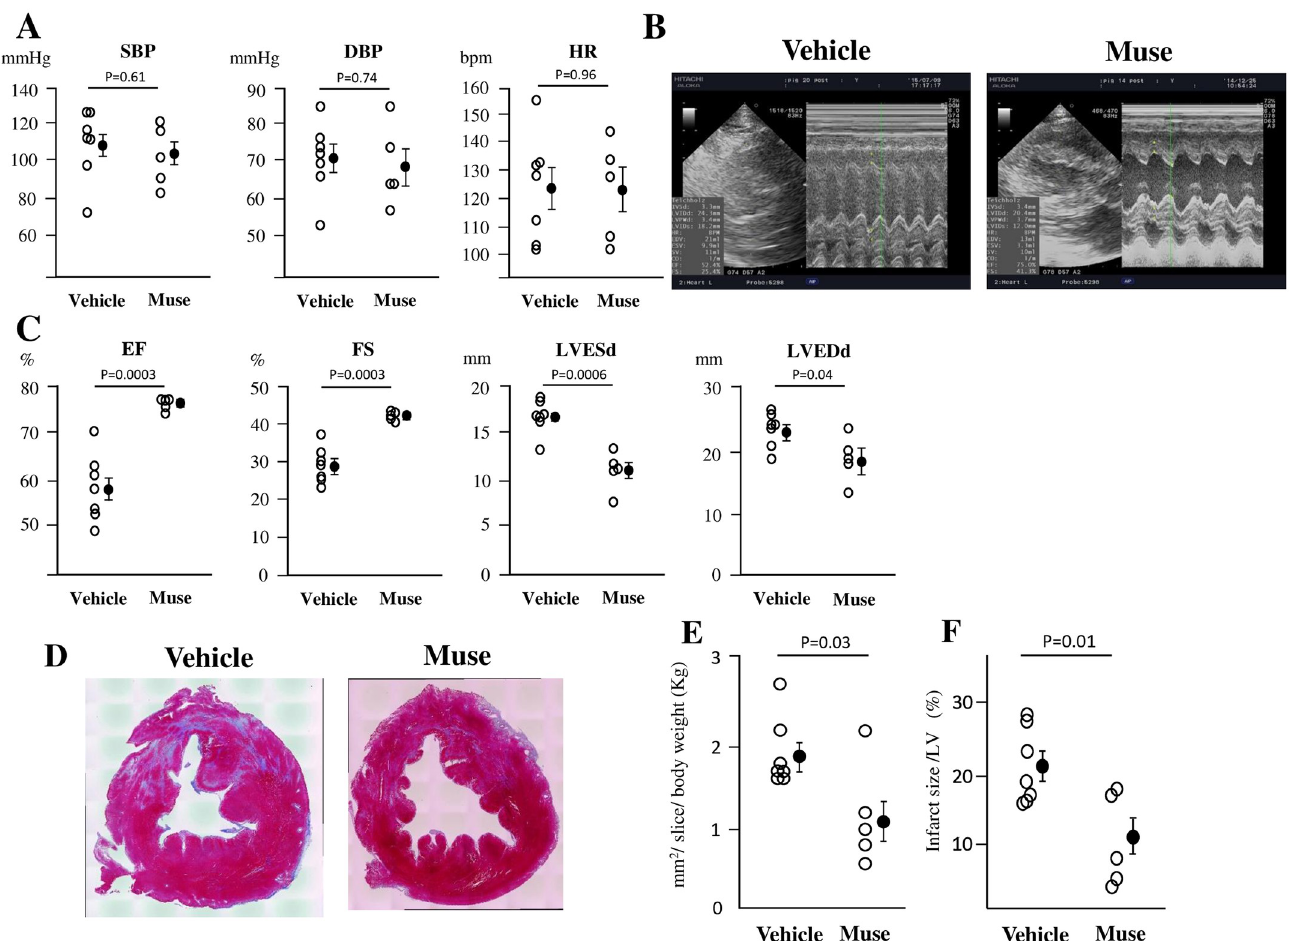
Fig 1. Cardiac function and myocardial infarct size. A: Systolic blood pressure (SBP), diastolic blood pressure (DBP) and heart rate (HR) in the Vehicle (n = 7) and Muse (n = 5) groups. B: Representative echocardiography in Vehicle and Muse groups. C: Left ventricular ejection fraction (LVEF), LV fractional shortening (LVFS), LV end-diastolic dimension (LVEDd), and LV end-systolic dimension (LVESd) in the Vehicle (n = 7) and Muse (n = 5) groups. D: Representative pictures of the Masson-Trichrome staining of cross-sections of LV in the Vehicle and Muse groups. Blue color-coded areas indicate the infarct regions and red-coded areas indicate the non-infarct regions of LV. E: Fibrosis area (mm 2 /slice/kg) in the Vehicle (n = 7) and Muse (n = 5) groups. F: Infarct size as a percentage of LV area (%) in the Vehicle (n = 7) and Muse (n = 5) groups.